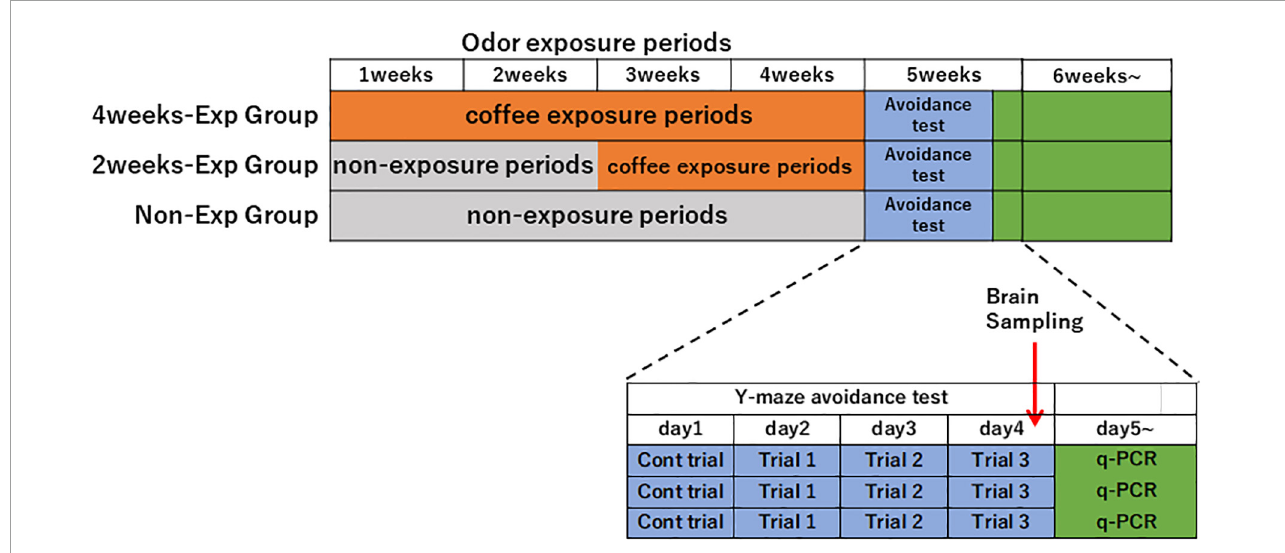
FIGURE1 Time schedule of repeated coffee odor exposure experiments after 2 or 4 weeks in the heterozygous oxytocin receptor (OCTR) ( ± ) mice. Heterozygous OXTR ( ± ) mice were divided into non-exposure, 2-week, and 4-week groups and exposed to coffee odor. After the 4-week odor exposure period, a Y-maze avoidance test for butyric acid was conducted. After trial 3 of the avoidance tests, brain samples from all mice were